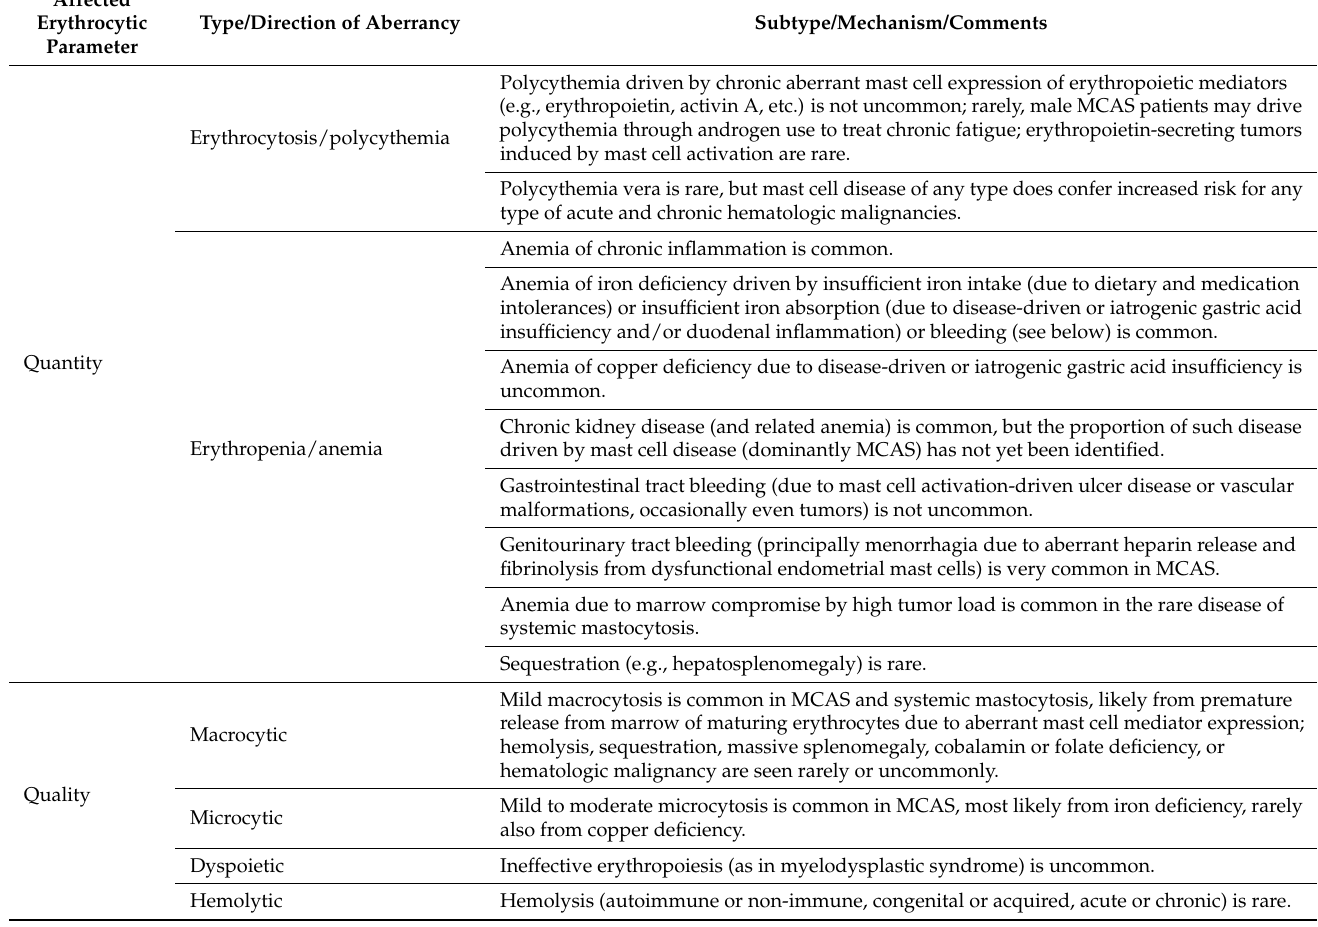
Table 2. Impacts of mast cell disease on quantities and qualities of